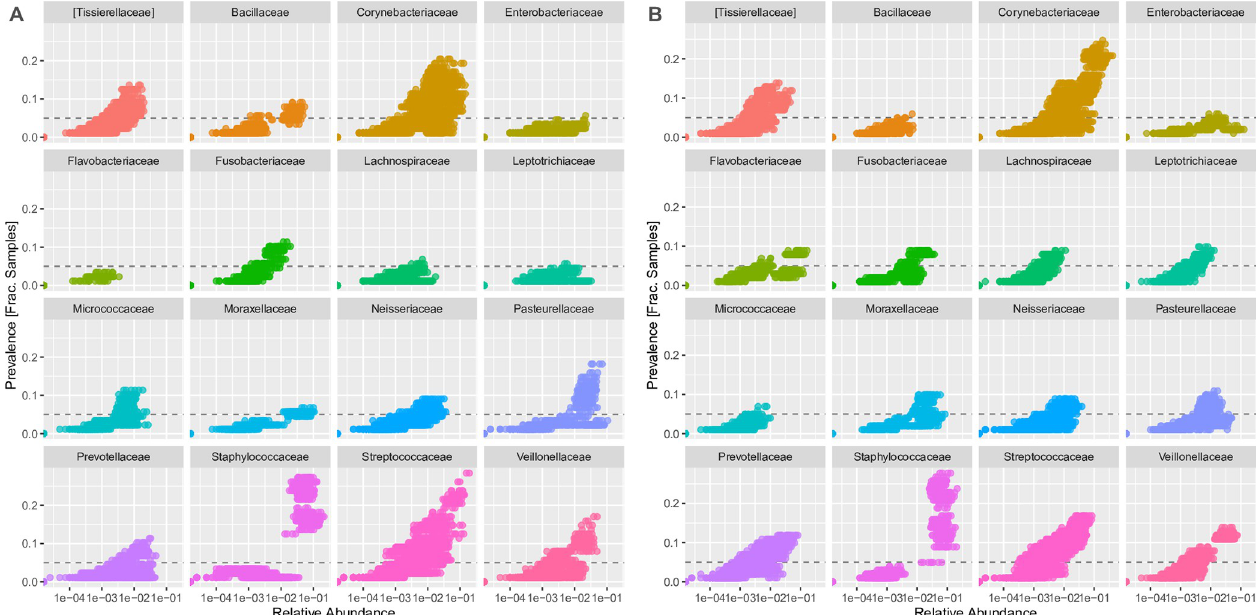
Fig 4. Family prevalence and relative abundance from 16S rRNA sequencing data. ASV detected in SARS-CoV-2 negative (A) and positive (B) samples. Prevalence is measured as fraction of samples in which the ASV was found. Families displayed were those with the highest overall prevalence.